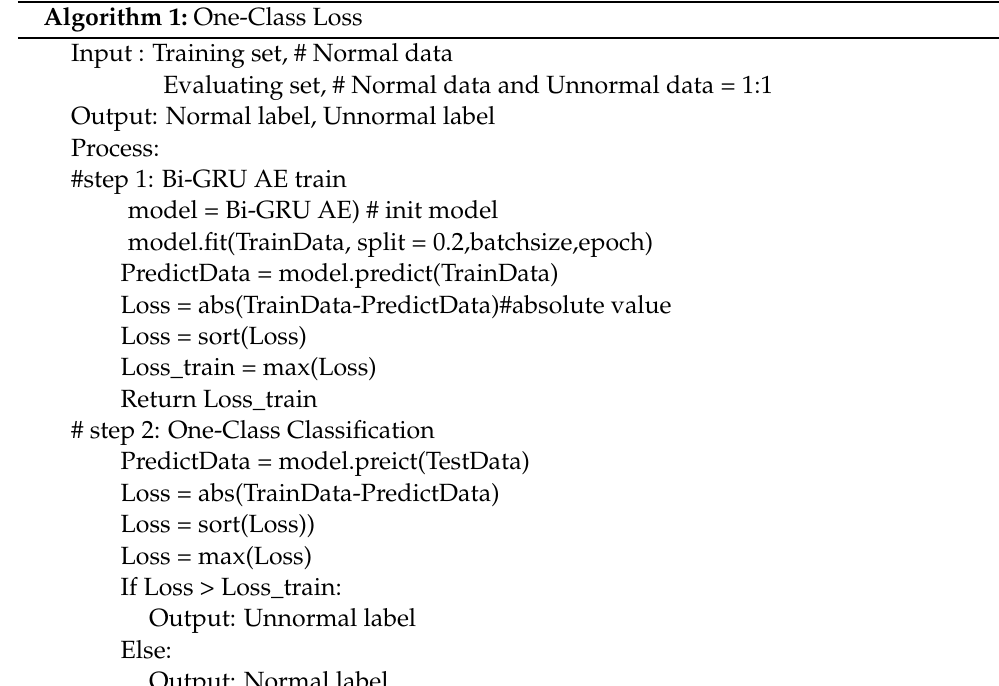
Algorithm 1: One-Class